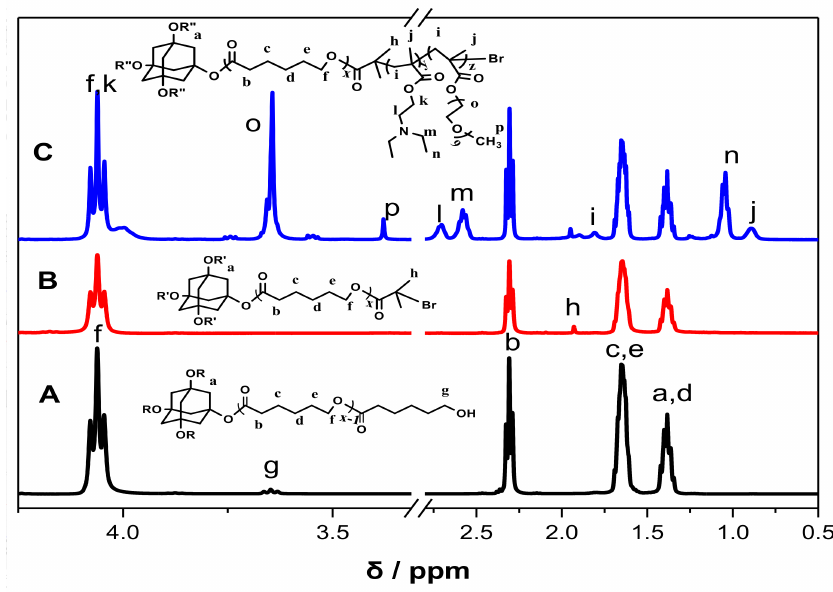
Figure 1. 1 H NMR spectra of Ad-(PCL) 4 ( A ), Ad-(PCL-Br) 4 ( B ) and Ad-(PCL- b -PDEAEMA- b - PPEGMA) 4 ( C